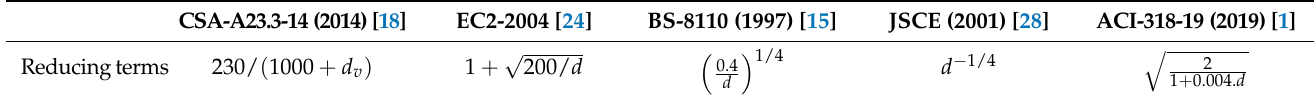
Table 1. Size effect reducing terms from prediction models.